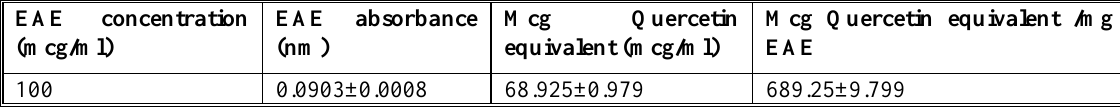
Each value represents the mean±SEM of 3 samples; EAE: ethyl acetate extract of Iraqi C.grandiflora